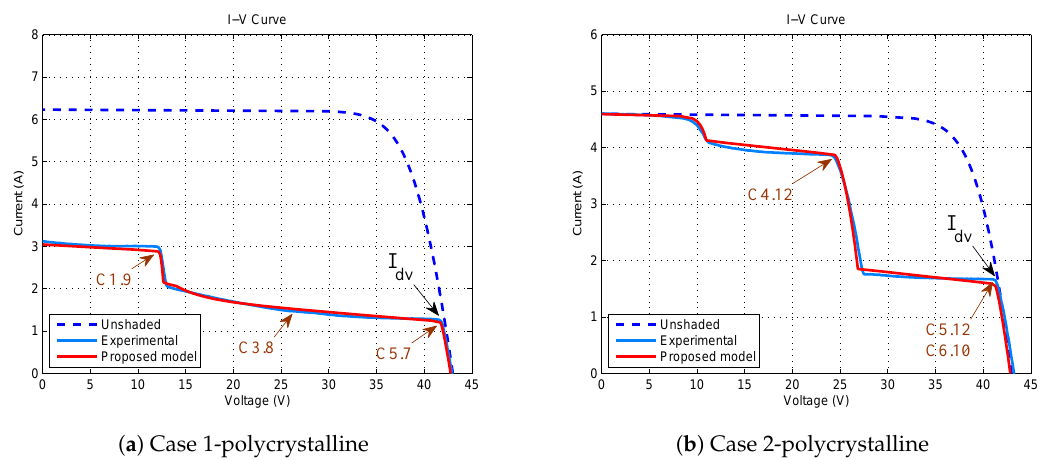
Figure 18. I–V curves for tests with polycrystalline PV module.